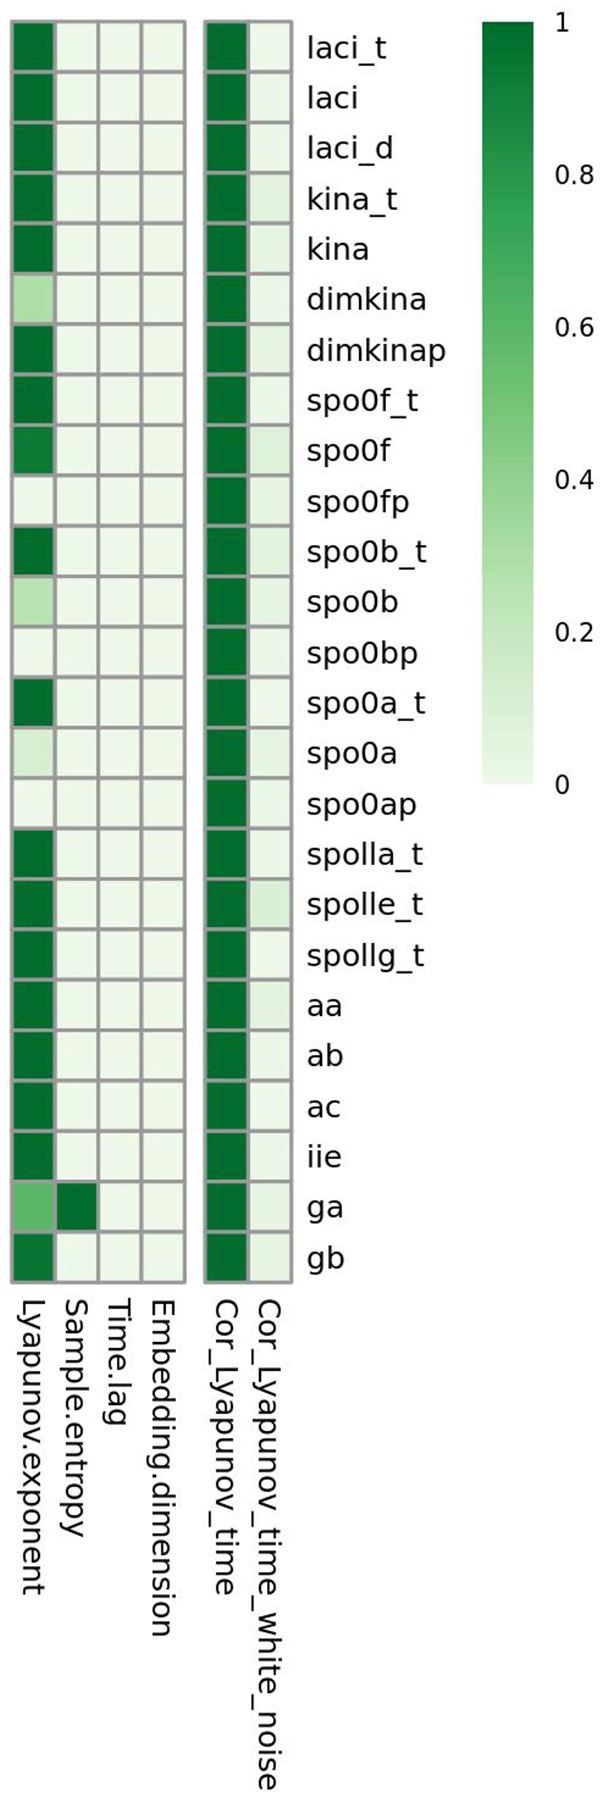
Complexity detected in the B. subtilis sporulation network dynamics is due to low dimensional chaos and not to noise. For the time series of molecular species spo0a, spo0b, spo0ap, spo0bp, spo0f, and spo0fp, all the indices of complexity are significantly greater than those for the time series of Gaussian white noise.